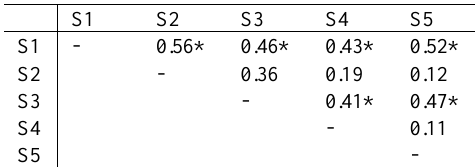
Table 3. Characteristics of the four test sectors.